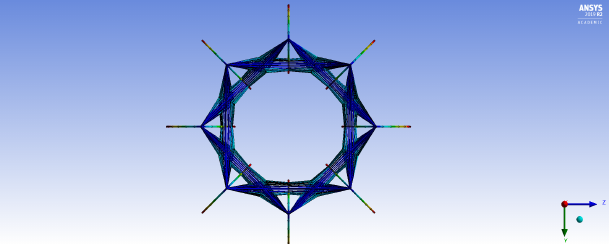
Figure 5. Local buckling of an outer longitudinal IsoTruss structure (end view)